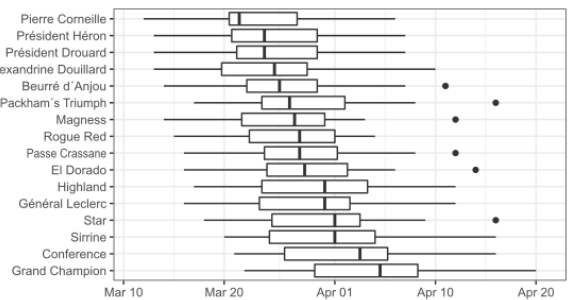
Figure 1. Flowering dates of 16 traditional pear cultivars grown in Zaragoza (northeastern Spain) during the periods 1986–1989, 1992–2007, and 2022. Boxplots represent the 20 years of observations. In each boxplot, a vertical line shows the median, and the hinges indicate the interquartile range (IQR, percentiles 25th to 75th). On each side of the boxes, the whiskers represent the greatest value located within 1.5 times the